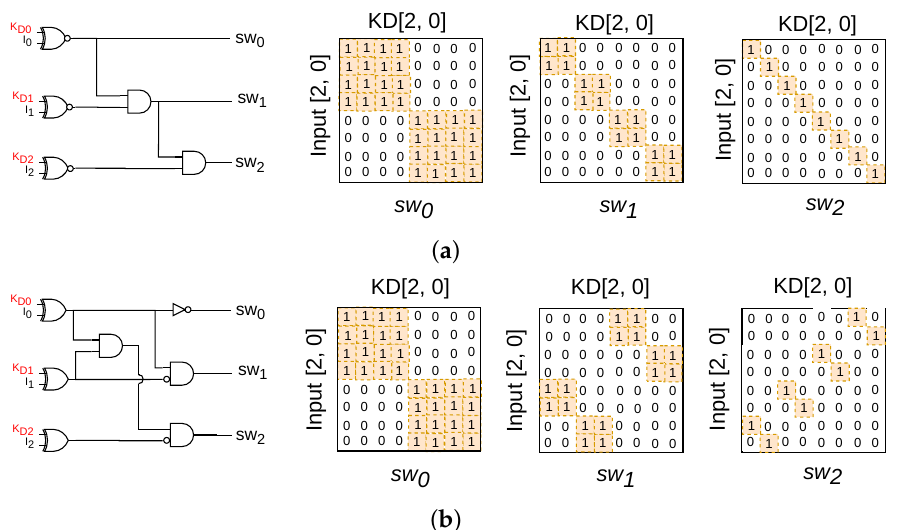
Figure 7. Switch controller structures (3-bits KD for example) and corresponding switch-signals truth tables: ( a ) the original structure, ( b ) the proposed improved structure avoiding overlapping in the inputs patterns that activate each